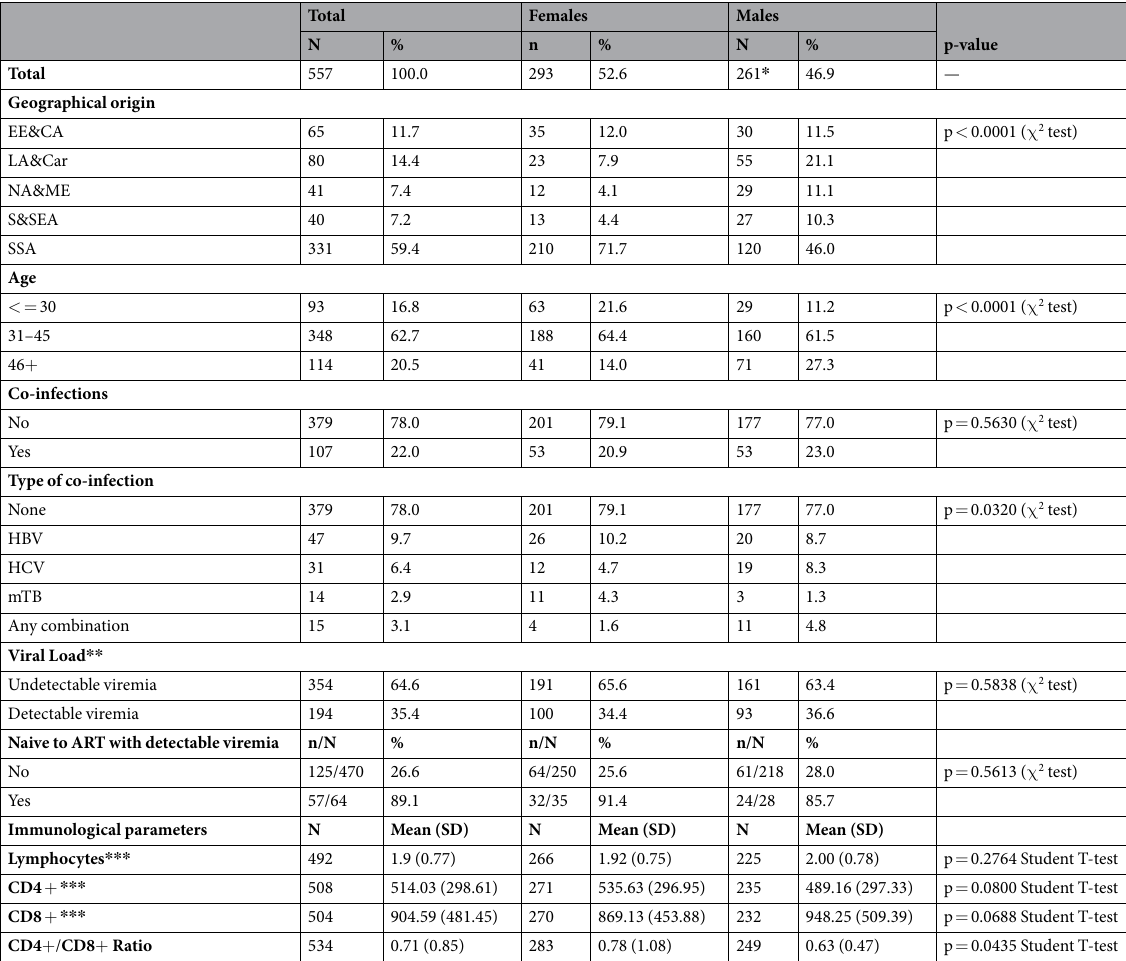
Table 1. Demographical, clinical, immunological and virological characteristics of the study group, stratified by gender. * It does not include two transgender patients and one patient whose gender was